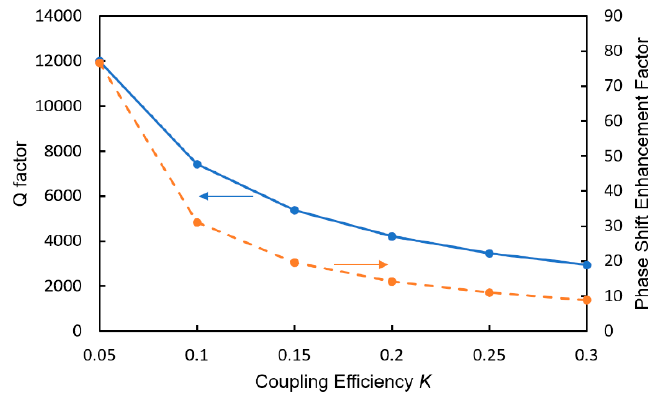
Figure 13. Schematic top view of the silicon-MRR-enhanced Mach–Zehnder interferometer (Si-MRR- MZI) sensor.